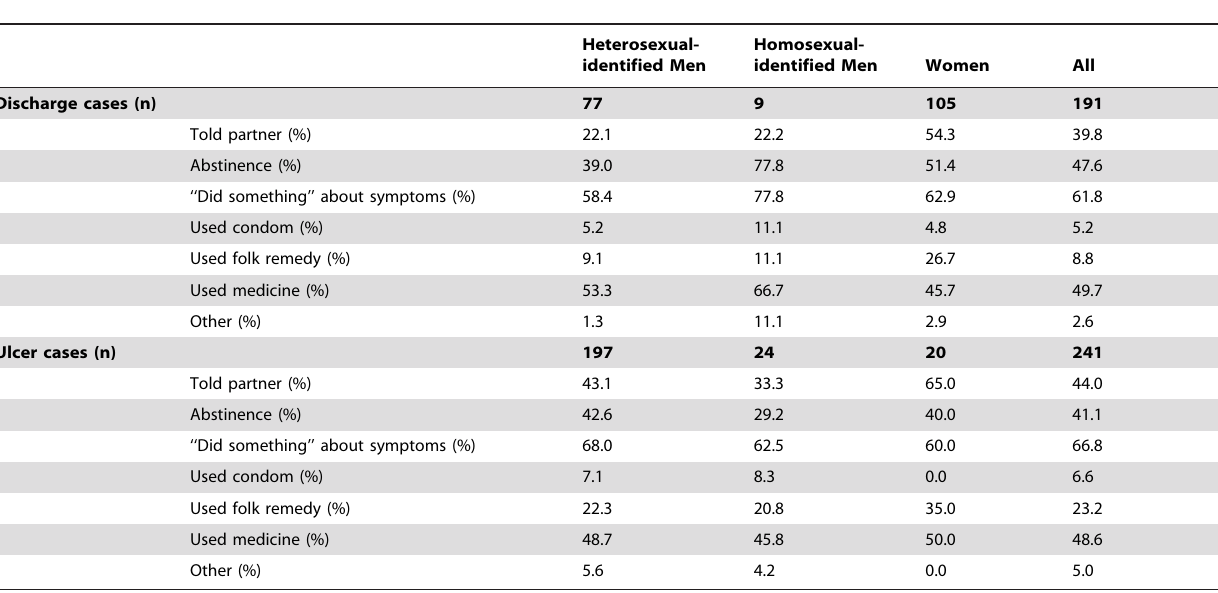
Table 2. Response to STI Symptoms (All Participants); Lima, Trujillo and Chiclayo, Peru;